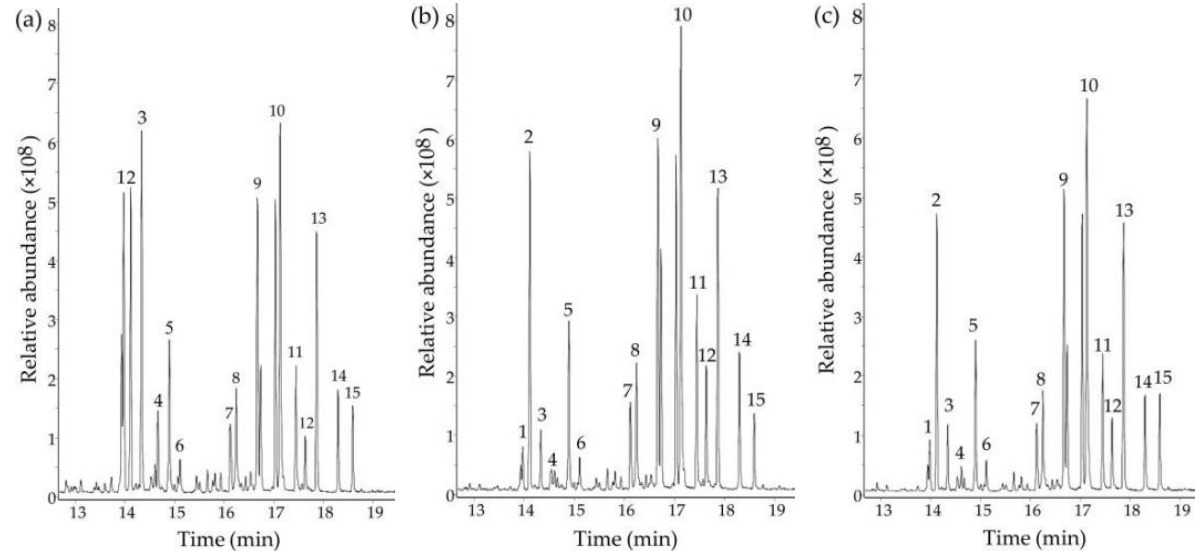
Figure 1. GC chromatograms for the hydrolyzed and derivated products from P. oleracea polysaccharides (PPS) with ( a ) Two selenylated PPS products SePPS1 and ( b ) SePPS2 ( c ). Peaks 1–4, arabinose, rhamnose, ribose, and fucose; peak 5, unidentified component; peaks 6–10, xylose, mannose, fructose, galactose, and glucose; peaks 11–12, unidentified components; peaks 13–14, galacturonic and glucuronic acids; peak 15, unidentified component.